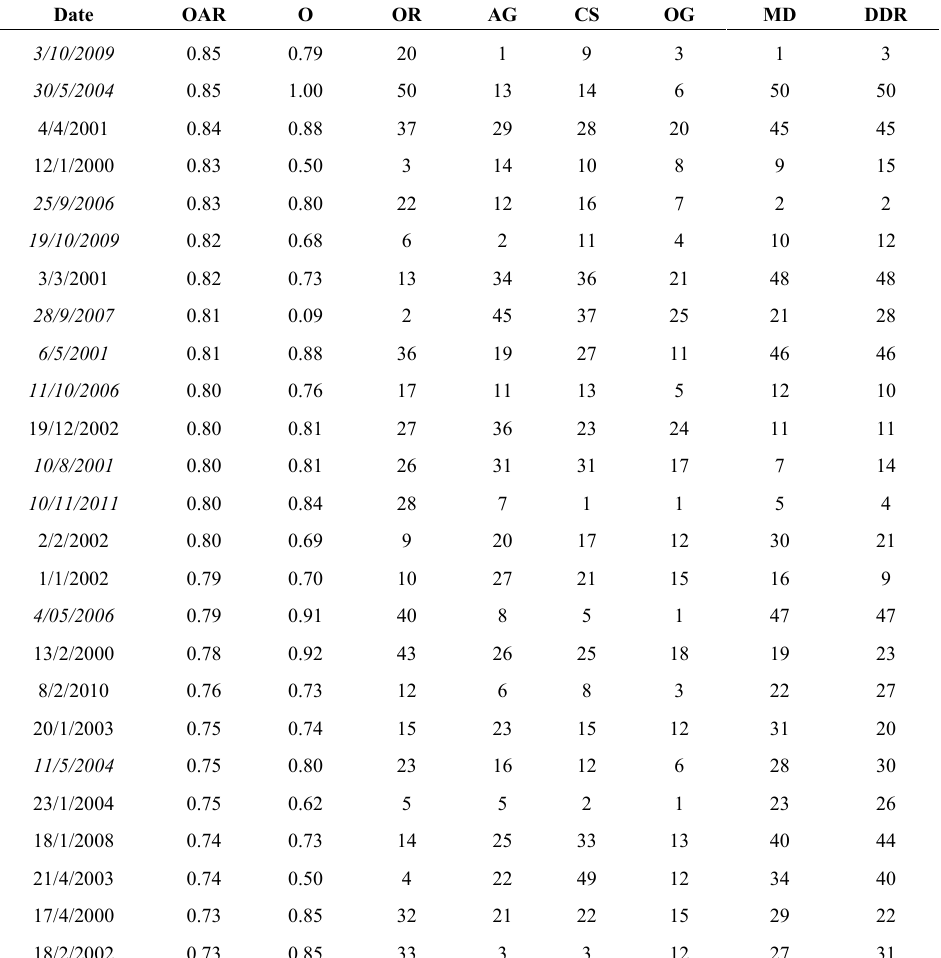
Table 7. Top 25 performing image dates (DD/MM/YYY) sorted in descending order by overall agreement rate (“OAR”). The remaining columns show omission rate (“O”) as well as rankings relative to all 50 study dates in terms of: omission rate rank (“OR”, 50—lowest), available gages rank (“AG”, 1 = highest number), clear sky rank (“CS”, 1 = lowest cloud percent), obscured gage rank (“OG”, 1 = fewest obscured), mean depth rank (“MD, 1=greatest average depth), and depth departure rank (“DDR”, 1 = greatest departure from 50 scene average). Dates in italics fall during “typical wet season.”